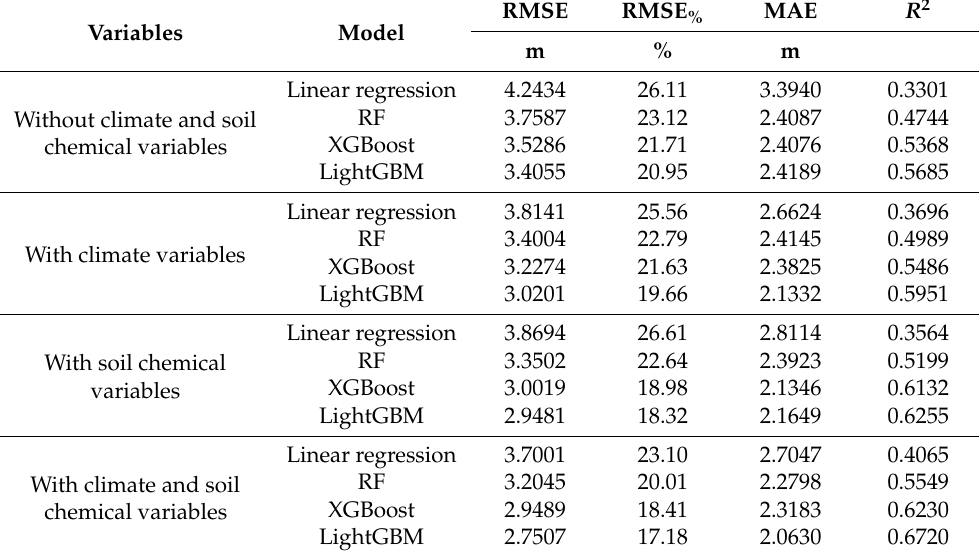
Table 4. The prediction accuracy of the SDH for different variable types obtained from parametric (linear regression) and non-parametric methods (RF, XGBoost, and